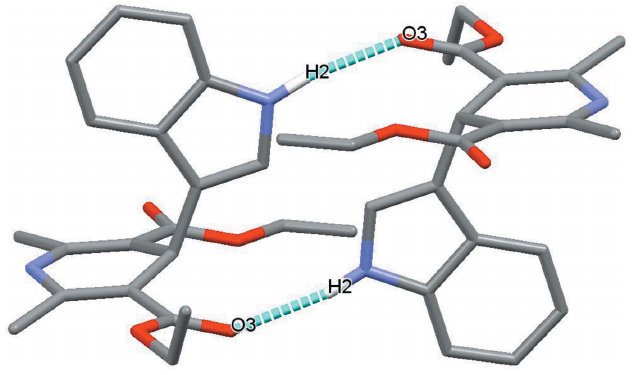
Figure 3 Part of the crystal structure showing N—H (cid:3)(cid:3)(cid:3) N hydrogen bonds as orange dash lines. For clarity only those H atoms involved in hydrogen bonding are shown.